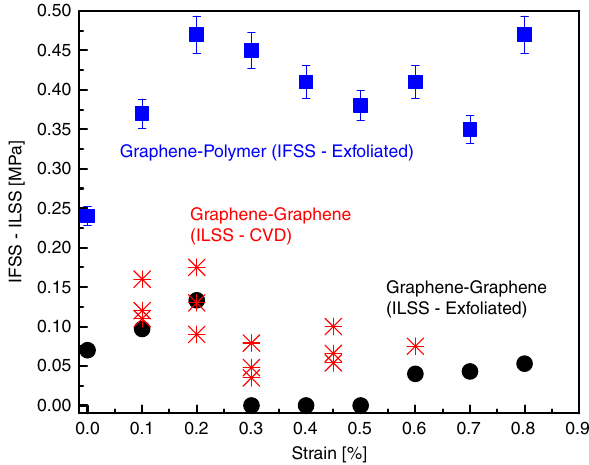
Fig. 4 Interface and interlayer shear stress. The interfacial shear stress (IFSS) for the cases of exfoliated single-layer graphene/polymer, exfoliated graphene/graphene and CVD graphene/graphene (ILSS) for various levels of tensile strain. The error bars represent standard